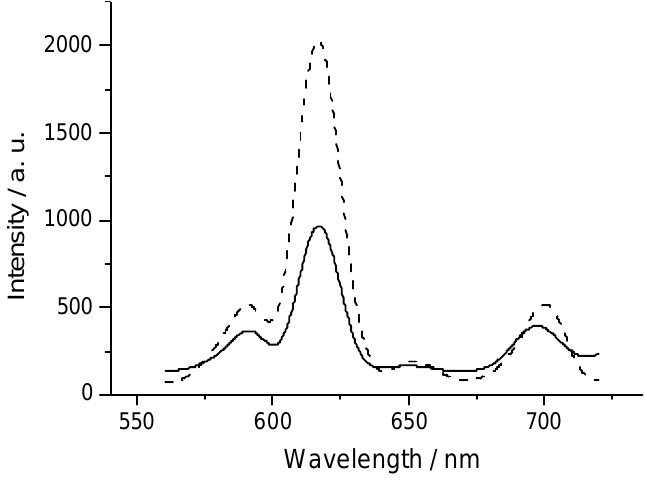
Figure 4: The photoluminescence spectra of the sample 1 (solid line) and 2 (dashed line). l = 396 exc